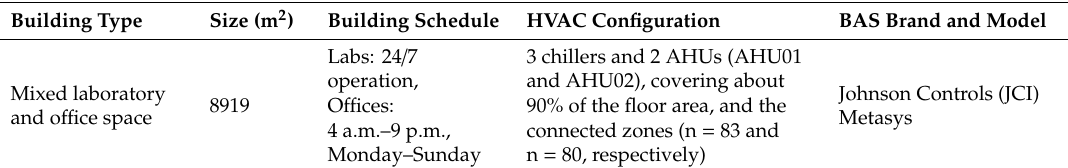
Table 2. Test site information.